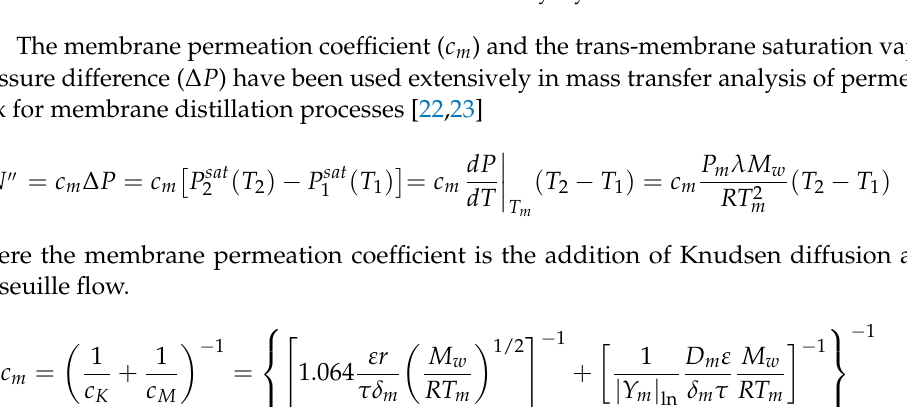
Figure 5. Mass transfer mechanisms and thermal boundary layer in the DCMD module.